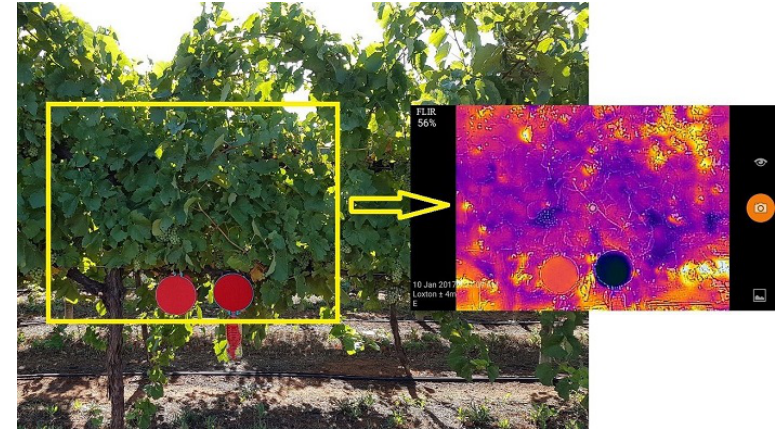
Figure 17. Grapevine water stress: Image of vines and respective thermal